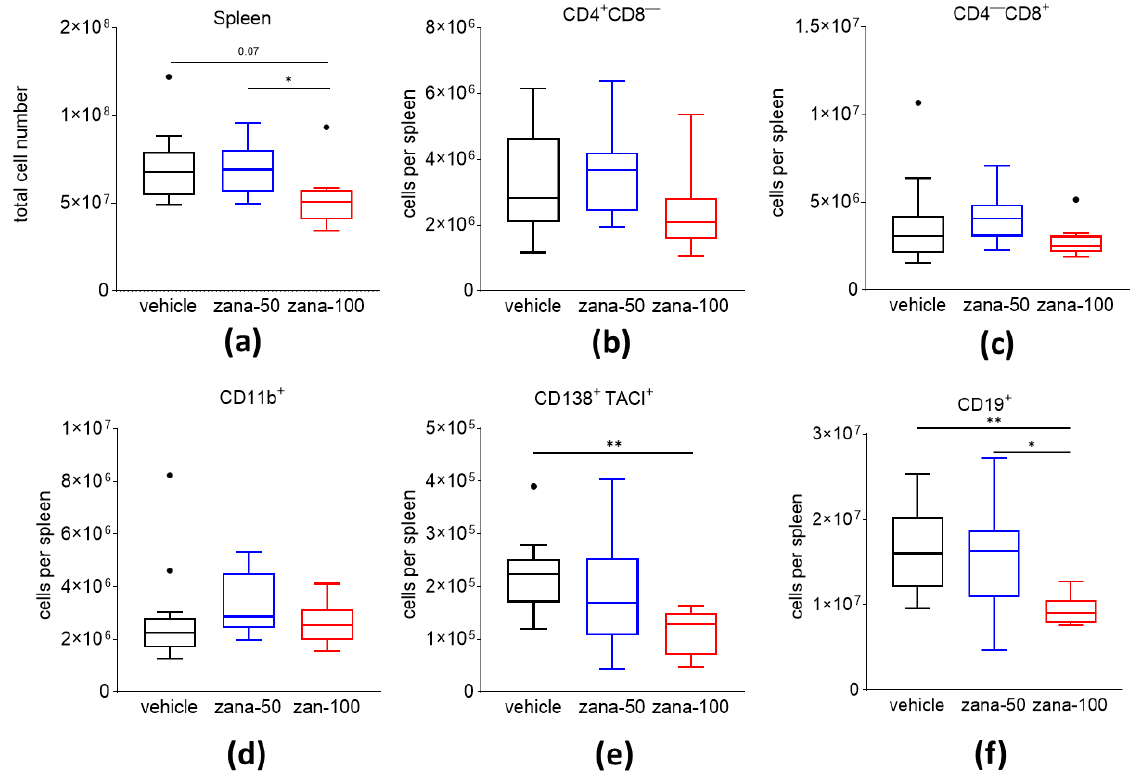
Figure 3. Zanamivir decreases the absolute cell number of CD138 + /TACI + plasma cells (PC) and CD19 + B cells in the spleens of CIA mice. ( a ) Total cell number in spleens of CIA mice. Immune cell populations (CD4 + CD8 − T cells ( b ), CD4 − /CD8 + -T cells ( c ), CD11b + cells ( d ), CD138 + /TACI + plasma cells ( e ) , and CD19 + B cells ( f ) were analyzed by flow cytometry. Absolute cell numbers were calculated. Results are presented as Tukey’s box- and whisker plots. Observations outside the whiskers are considered outliers and presented as black dots. * p ≤ 0.05; ** p ≤ 0.01. One-way ANOVA with Tukey’s multiple comparisons test was used for statistical analysis .